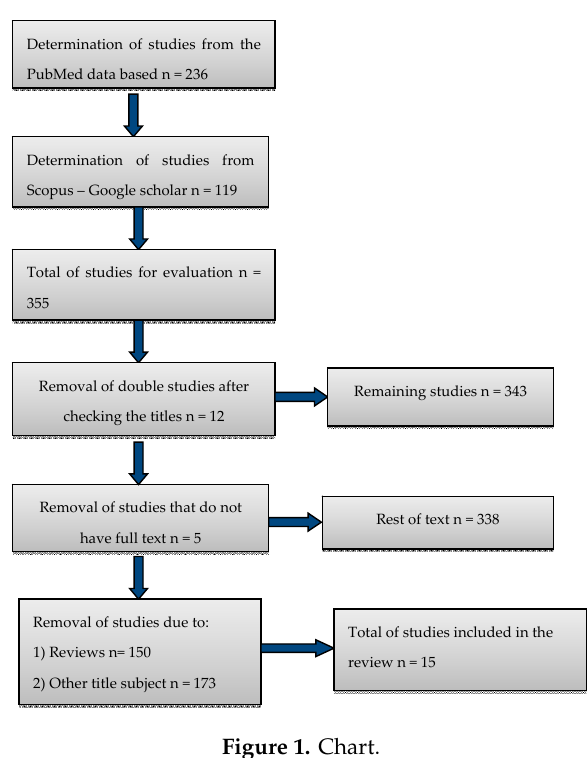
Figure 1. Chart. Figure 1. Chart. Table 1. Evaluation ofsurveying methodological quality studies. Table 1. Evaluation ofsurveying methodological quality